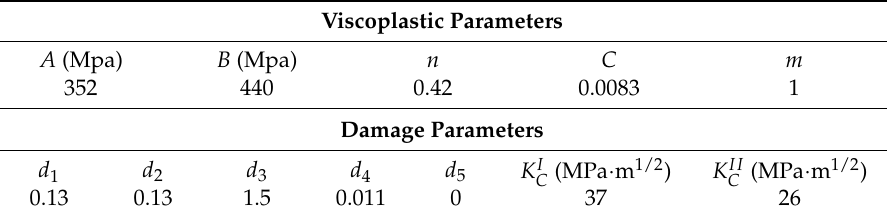
Table 4. Johnson-Cook viscoplastic-damage parameters of AA2024-T351